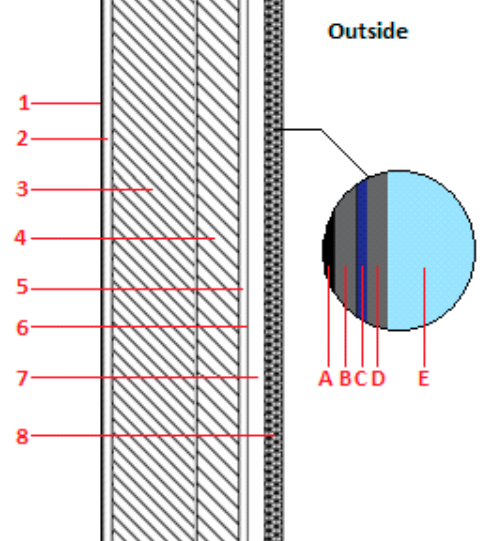
Figure 2. A fragment of the cross-section of the external wall of a building with a PV installation (layers 1–8 described in text).